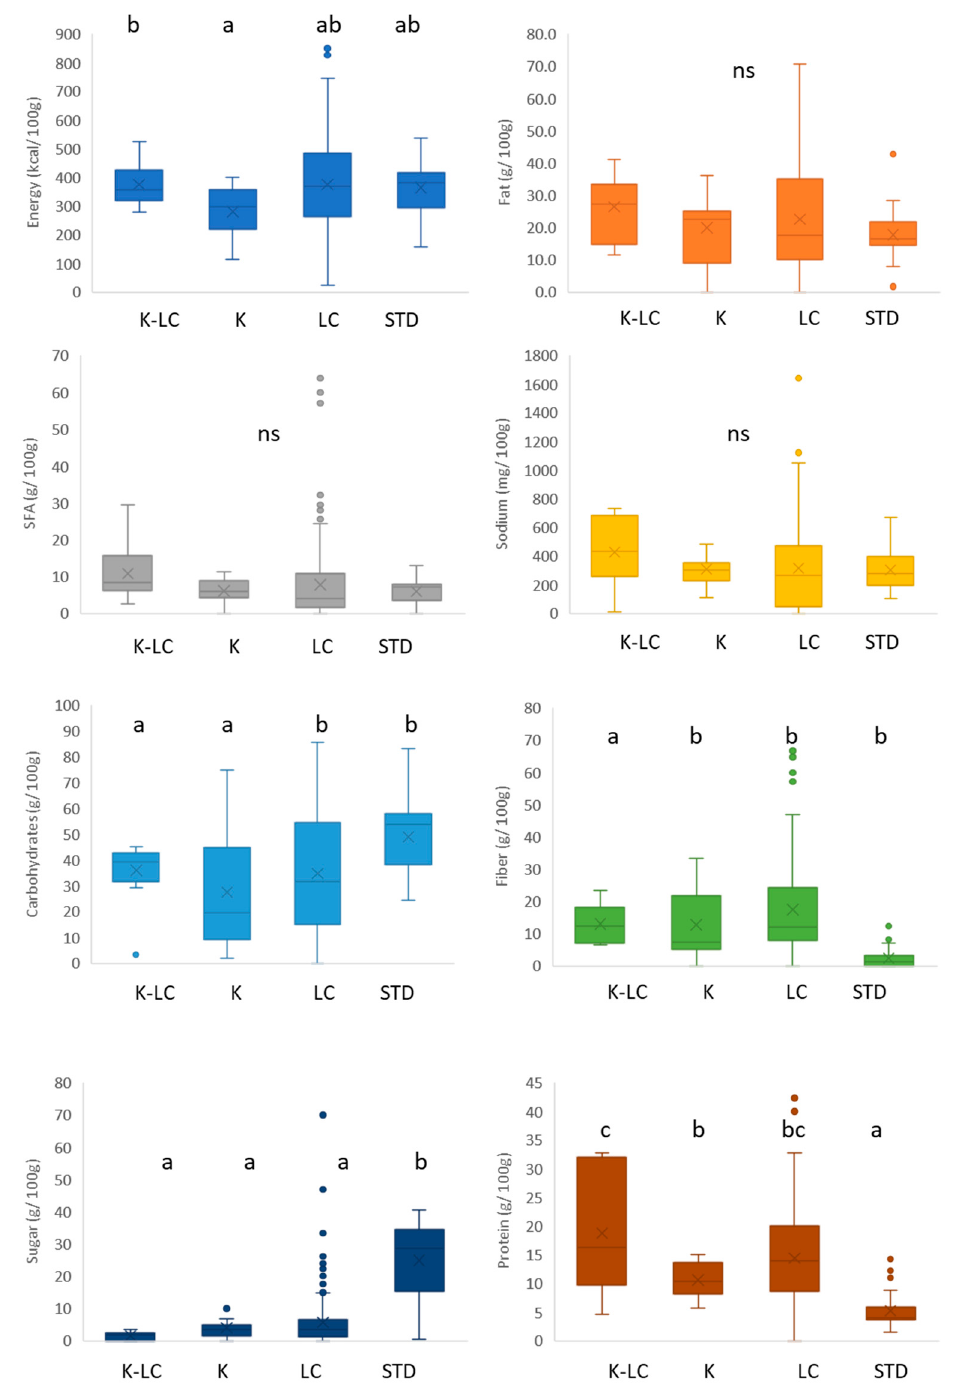
Figure 4. Nutritional composition of gluten-free cakes, pastries and sweet goods labeled ketogenic and/or low carb. K-LC: ketogenic and low carb; K: ketogenic; LC: low carb; STD: standard; different letters indicate significant difference at p < 0.05; ns: non-significant; the box-plot legend: the box is limited by the lower (Q1 = 25th) and upper (Q3 = 75th) quartile; the median is the horizontal line dividing the box; whiskers above and below the box indicate the 10th and 90th percentiles; outliers: are the points outside the quartile 10–90th